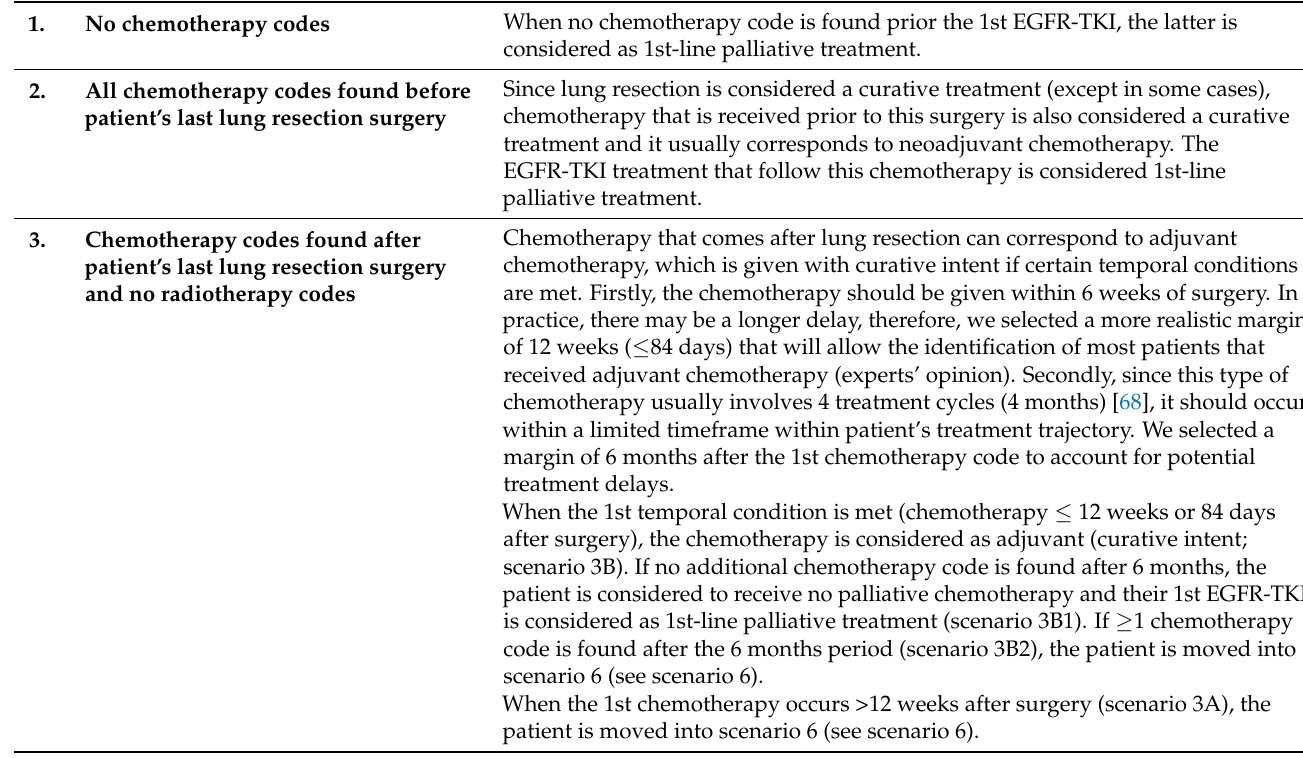
Table A2. Treatment Scenarios and Rules to Identify Chemotherapy